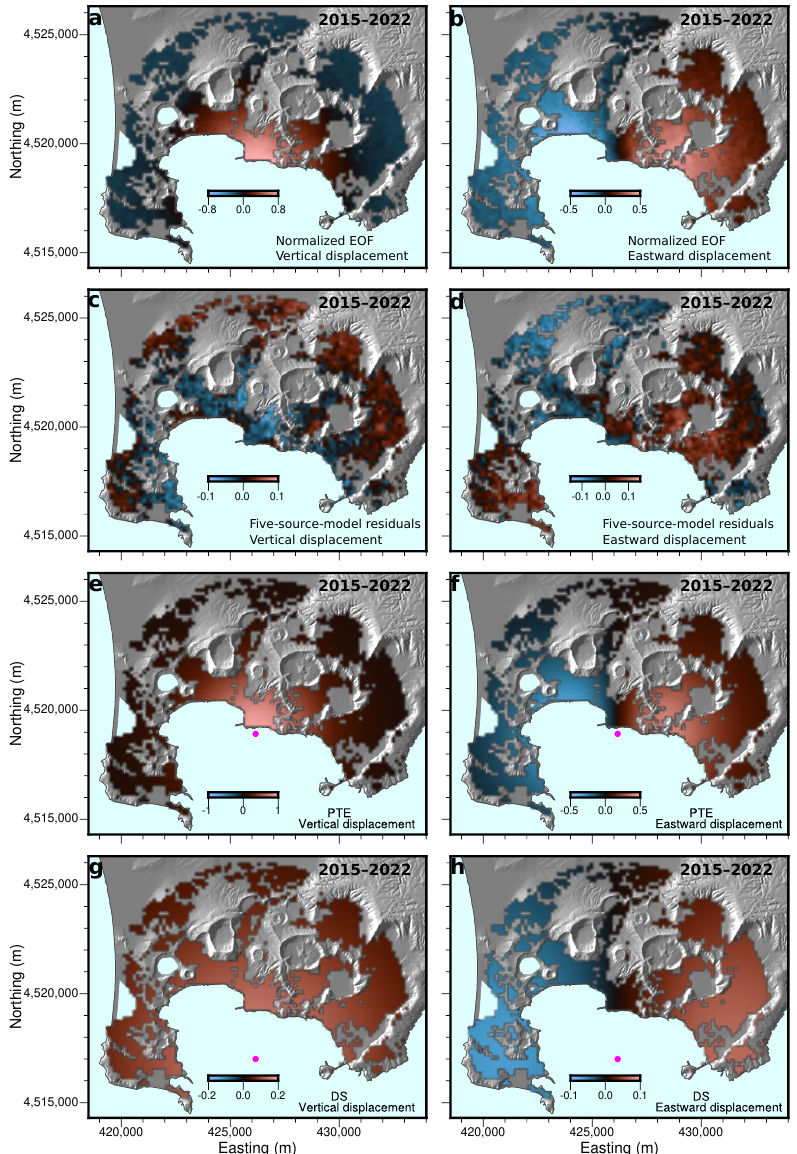
Figure 11. Modeling of the normalized 2015–2022 EOFs. ( a , b ) Normalized vertical and horizontal EOFs (˜ h v and ˜ h e in Equation (2), respectively), redrawn from Figure 7a,b. ( c , d ) Residuals after 2 2 subtracting the cumulative contribution of the PTE, DS, PS, RFI and PMC. ( e , f ) Contribution of the (cid:0) (cid:0) (cid:1) (cid:1) a 2,1 / r v f v a 2,1 / r v f e PTE, i.e., and in Equation (2), respectively. ( g , h ) Contribution of the DS, 2 2 1 1 (cid:0) (cid:0) (cid:1) (cid:1) a 2,2 / r v a 2,2 / r v f v f e i.e., and in Equation (2), respectively. The magenta dot in panels ( e – h ) gives 2 2 2 2 the center position of the related